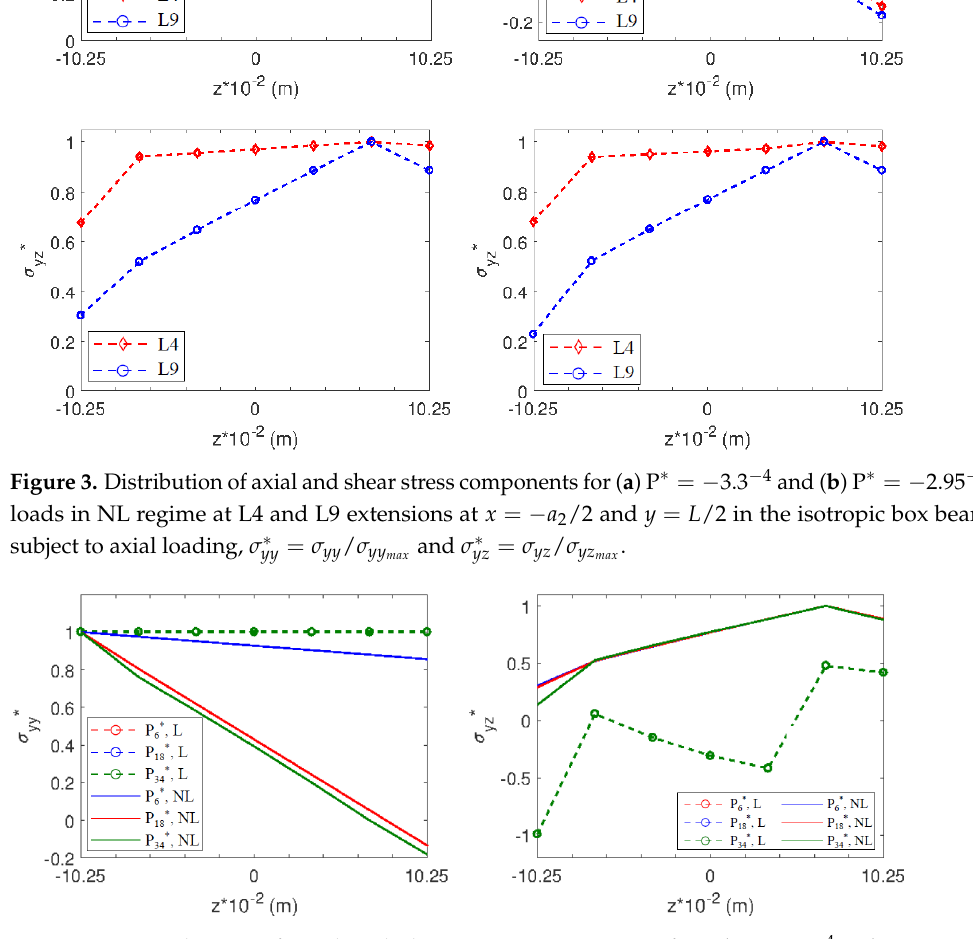
Figure 4. Distribution of axial and shear stress components for P ∗ = − 3.0 − 3 values in L9 for the isotropic box beam subjected to axial loading, σ ∗ and P ∗ 34 and σ ∗ yz = σ yz / σ yz (at x = − a 2 /2 and y = L /2 max